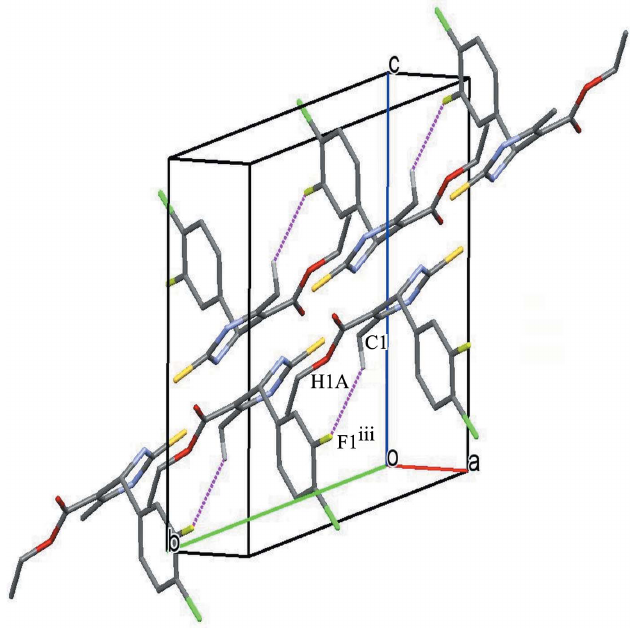
Figure 3 Unit-cell packing of the title compound, showing C—H (cid:3)(cid:3)(cid:3) F interactions with dotted lines. H atoms not involved in hydrogen bonding have been excluded. See Table 1 for symmetry code.